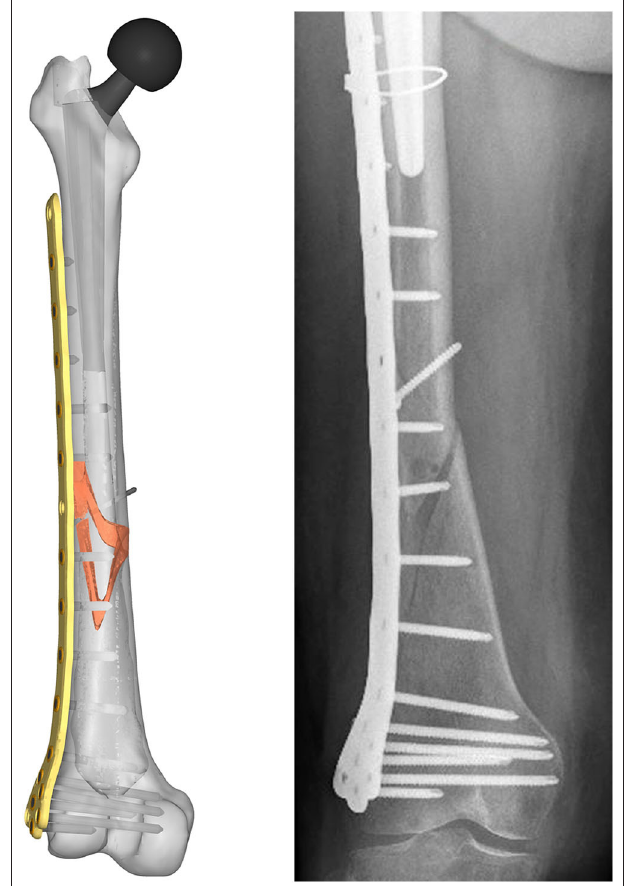
FIGURE 4 | Resulting assembled geometrical model (Left) compared with the corresponding x-ray image (Right)